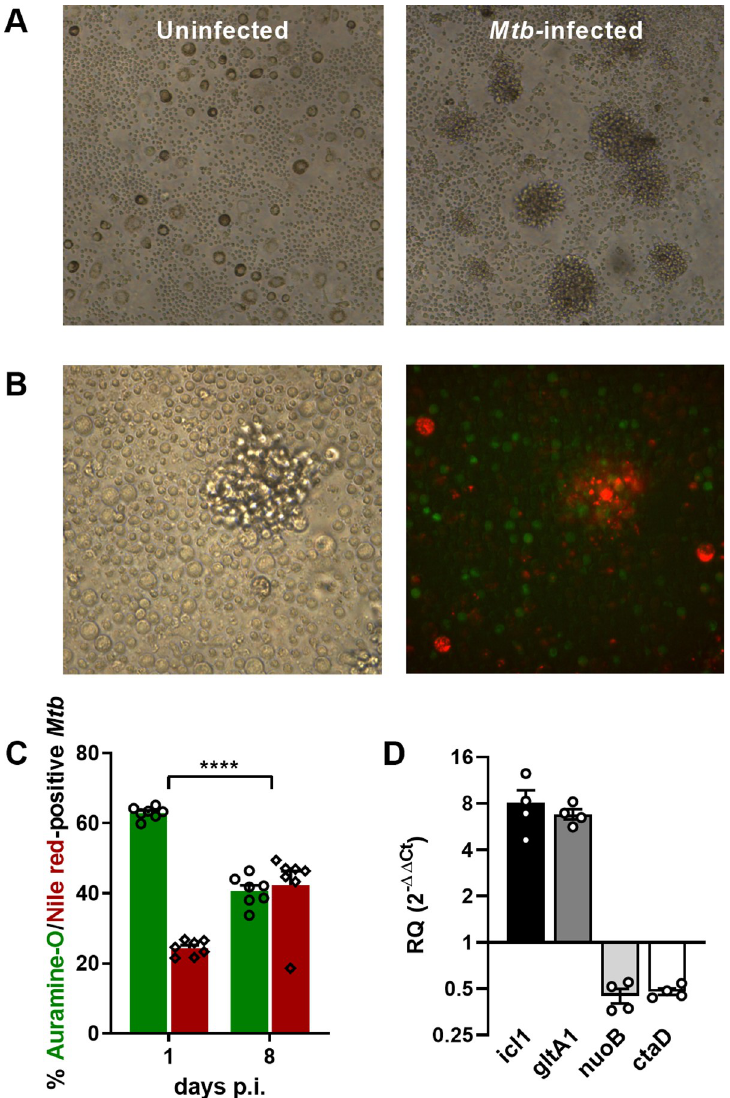
Fig 1. Human, in-vitro granulomas mimic dormant-like Mtb features. (A) Representative bright-field microscopy pictures of 3D in-vitro granulomas formed 8 days post-infection with Mtb H37Rv compared to uninfected PBMCs. (B) Representative structure of in-vitro granulomas under bright-field (left panel) and fluorescence microscopy (right panel). Monocytes/macrophages were labeled in orange and CD4 + T cells in green. (C) Percentages of auramine-O- (green) and Nile red-positive (red) Mtb quantified by fluorescence microscopy (mean ± SEM from 7 independent donors) before (1 day post-infection) or after (8 days post-infection) granuloma formation. Statistical analysis was performed using a generalized linear mixed-effects model; ���� , p < 0.0001. (D) Relative expression values for icl1 , gltA1 , nuoB and ctaD after granuloma formation (8 days post-infection) determined by qRT-PCR (mean ± SEM from 4 independent donors). Results are expressed as fold change in log2 scale relative to an aerobically-grown, mid-log Mtb culture, using 16S rRNA as the endogenous